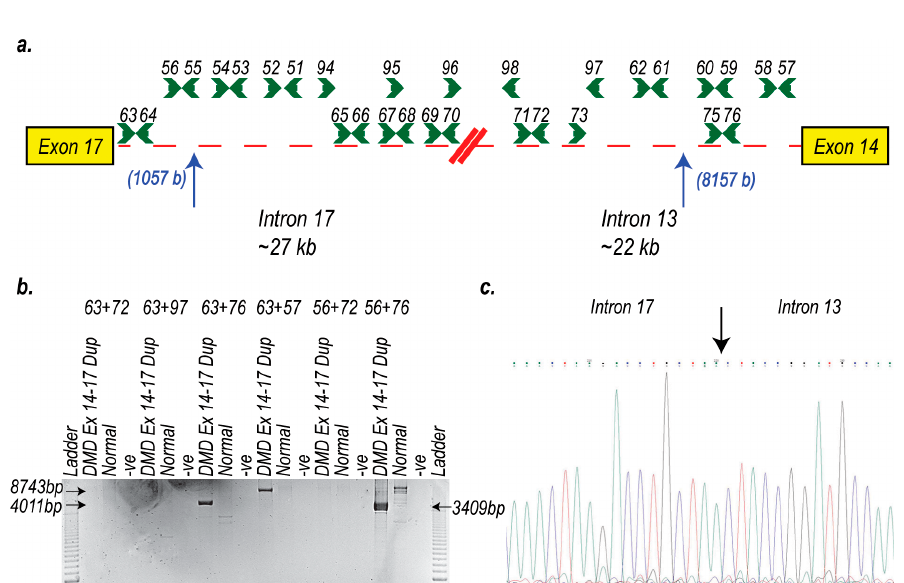
Figure 6. PCR analysis of the intron 17: intron 13 junction to map the breakpoint of a dystrophic patient myogenic cell strain with a duplication of exons 14–17. DNA was extracted from cells derived from a patient carrying a dystrophin exon 14–17 duplication and from myogenic cells from a healthy donor. PCRs were undertaken across intron 17 and 13 to analyse the breakpoint between the proximal exon 17 and distal exon 14. ( a ) Intron 13 and intron 17 junction showing primer locations across both introns; ( b ) PCRs showing products of 3409 bp (56+76), 4011 bp (63+76) and 8743 bp (63+57) present in the exon 14–17 duplication patient DNA but not in DNA from the healthy donor. -ve: no template PCR negative control; ( c ) Sequence chromatogram showing the junction of intron 17 and intron 13.